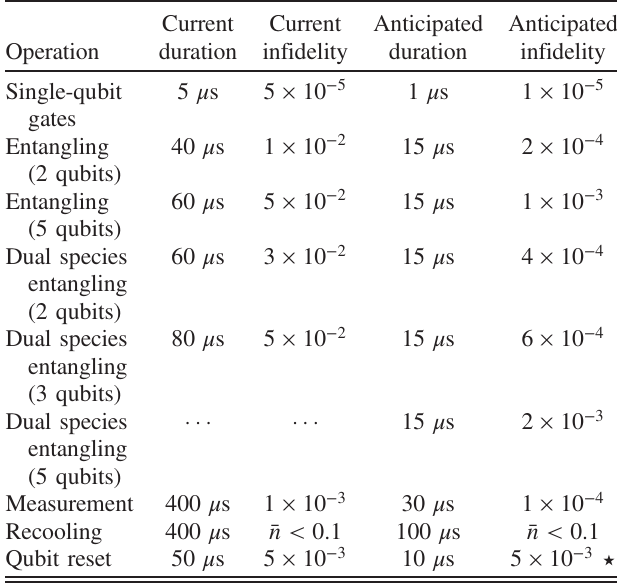
TABLE II. Current and anticipated gate-operation infidelities and durations. Single-qubit operations are a 90-degree rotation on the Bloch sphere; whole entangling operations correspond to fully entangling Mølmer-Sørensen operations (see Sec. III). The reported dual-species operations have been performed in a 9 Be þ – 40 Ca þ crystal. For the parameter marked by the ⋆ symbol, i.e., the anticipated value of the qubit-reset fidelity, numerical simulations were performed for both the value 5 × 10 − 3 and the value 1 × 10 − 4